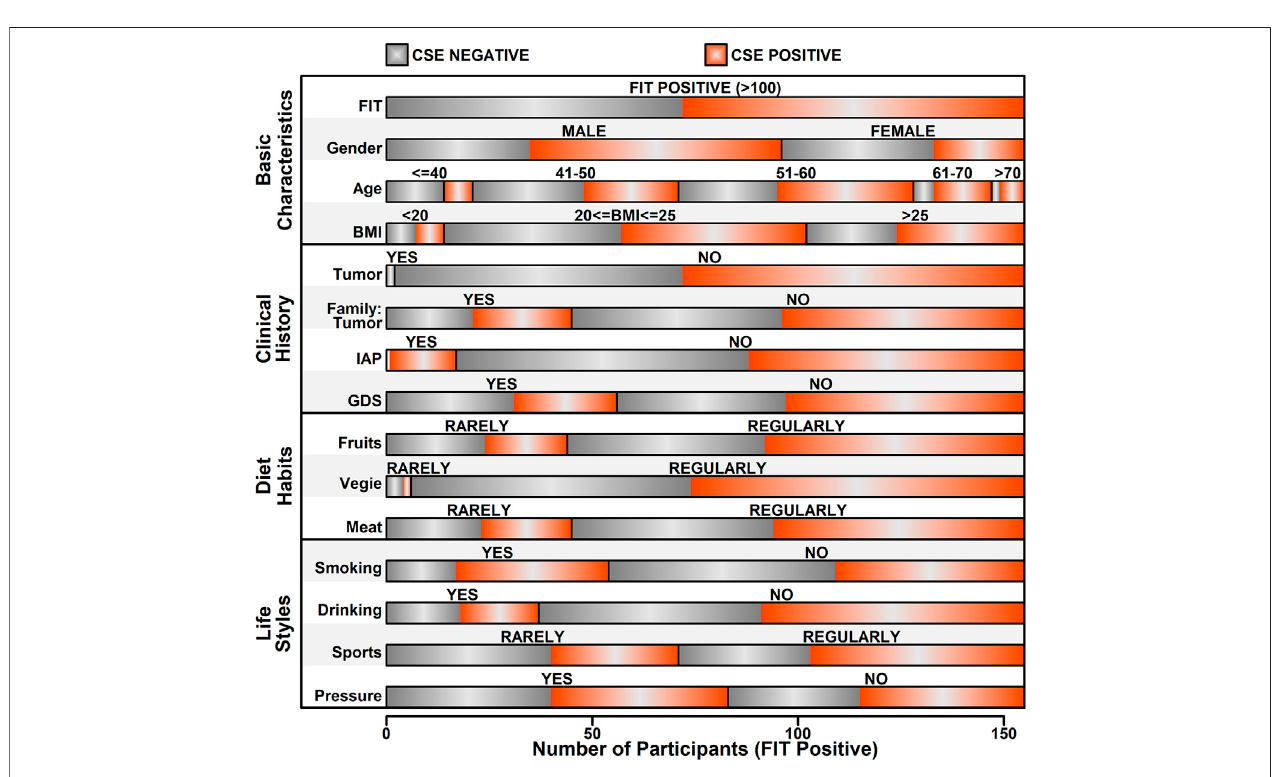
FIGURE 3 | Summary of the features of FIT positive